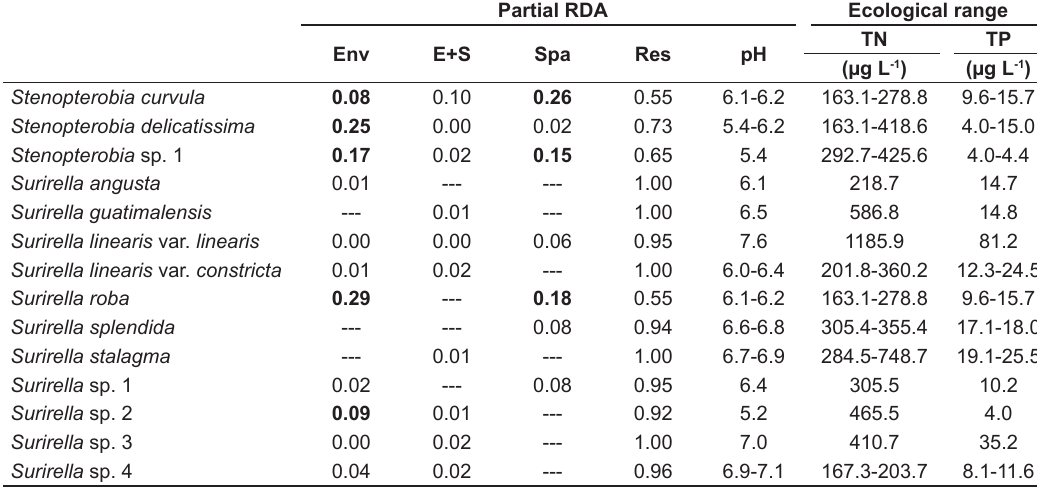
Table 3. Results of partial RDA analysis and ecological range for each